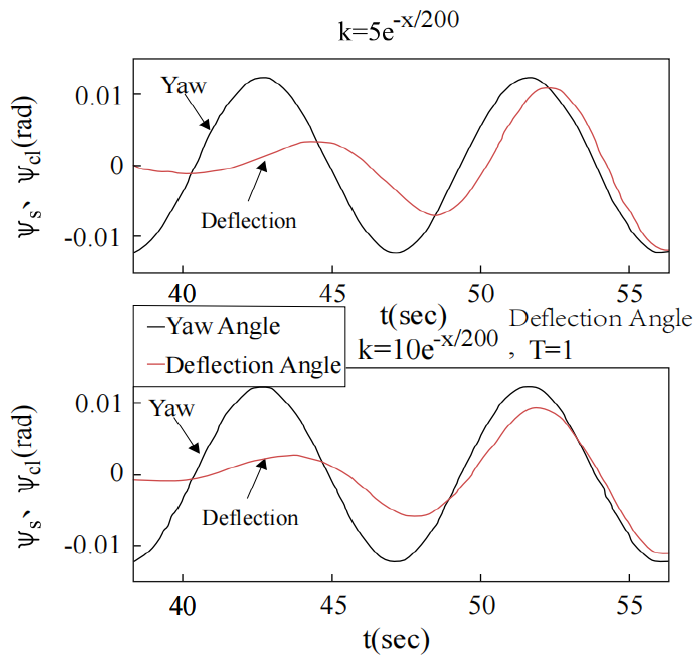
Figure 44. Tracking response curves of measurement axis under integral and inertial tracking strat- egies.